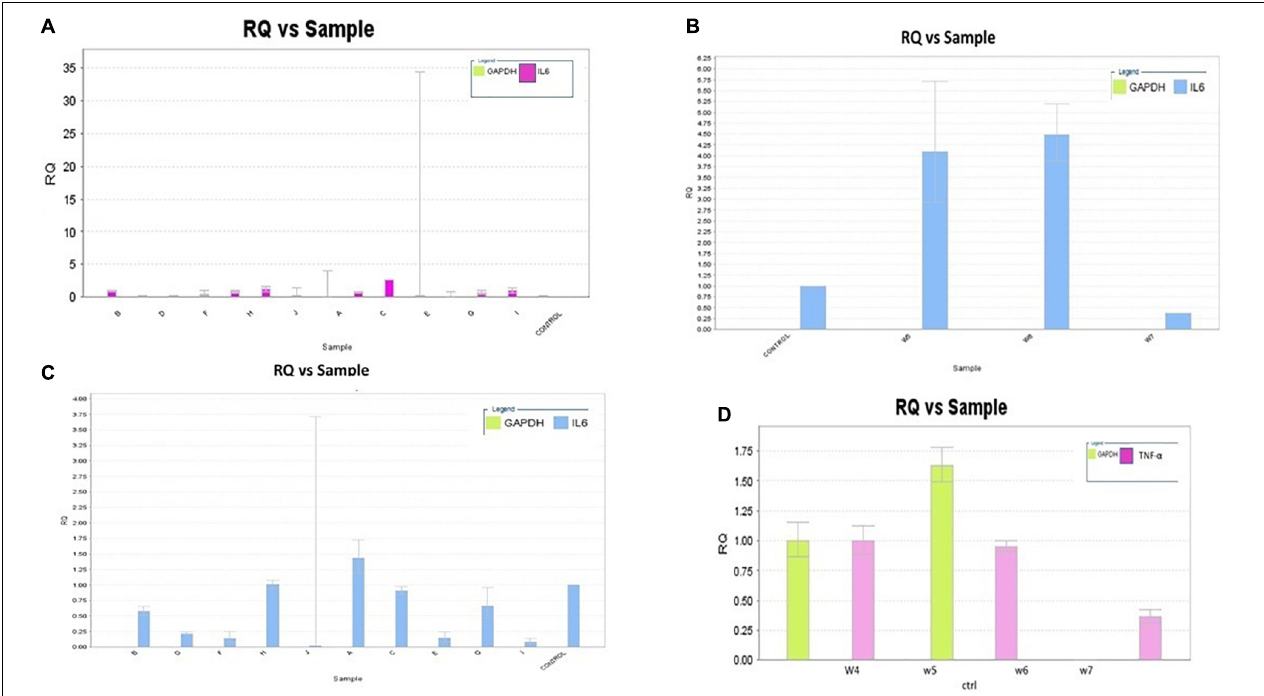
FIGURE 5 | (A) IL-6 mRNA expression on low warfarin dose. Samples are plotted on the x -axis and RQ on the y -axis. Each bar shows the set of sample values of a detector. The detector for the IL-6 gene is shown in purple. The error bars show the RQ min/max expression levels that measured the standard error of the mean expression level (RQ value). (B) IL-6 mRNA expression on medium warfarin dose. The detector for IL-6 gene is shown in blue. The error bars show the RQ min/max expression levels that measure the standard error of the mean expression level (RQ value). (C) IL-6 mRNA expression on high warfarin dose. Samples are plotted on the x-axis and RQ on the y -axis. Each bar shows the set of sample values of a detector. The detector for the IL-6 gene is shown in blue. The error bars show the RQ min/max expression levels that measured the standard error of the mean expression level (RQ value). (D) TNF- α mRNA expression on high warfarin dose. The detector for the TNF- α gene is shown in purple. The error bars show the RQ min/max expression levels that measured the standard error of the mean expression level (RQ value).